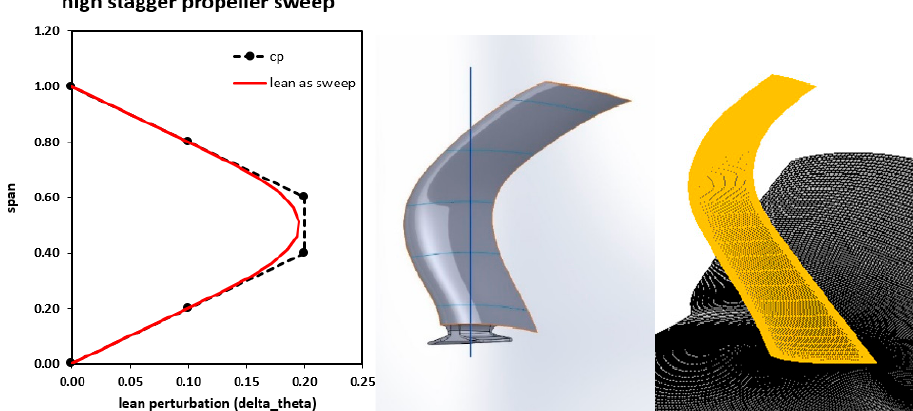
Figure 33. Highly staggered swept propeller with supercritical NASA airfoil at the tip.